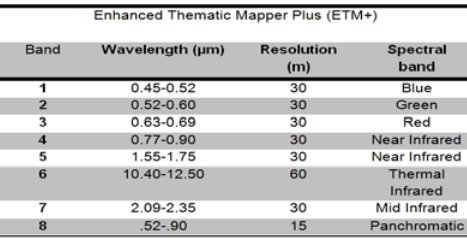
Table 3: Bands of the ETM+ sensor. Source: (De Maeyer et al. 2011; United States Geological Land Survey 2010).